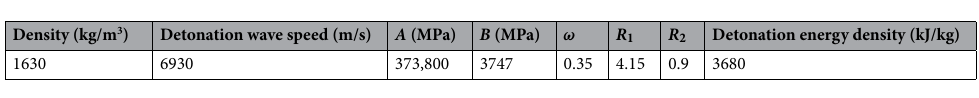
Table 4. Material properties of